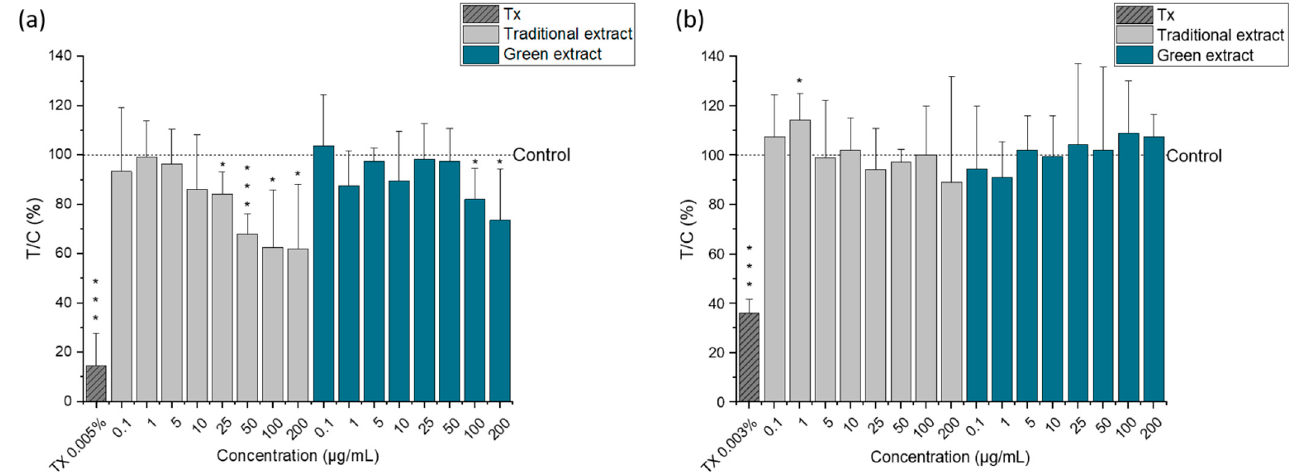
Figure 4. Cell viability of HCT-116 cells ( a ) and HCEC-1CT ( b ) after 24 h incubation with different concentrations of the omega-3 lipid extracts produced by the traditional method (traditional extract) and the green method by using Saczyme (green extract) measured by SRB assay. Triton X (Tx; 0.005 or 0.003%) was used as positive control. Results are presented as mean + SD normalized to DMSO solvent control (0.5%; T/C in %) (n = 5). Statistical differences compared to the DMSO solvent control were calculated with a one-sample Student’s t -test (* p , *** p < 0.05, 0.01, 0.001). Significant differences among the test concentrations were calculated with one-way ANOVA ( p < 0.05, a–c). Moreover, for selected experimental conditions (HCT-116 cell line and selected con- centrations: 1, 25, 50, 100, and 200 µg/mL), the LDH release assay was also performed to